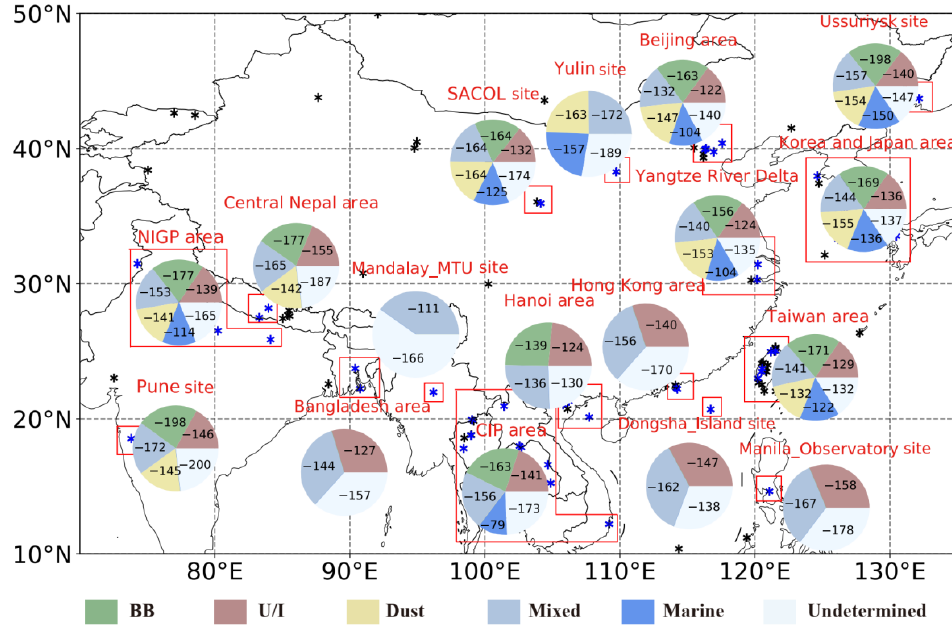
Figure 12. The same as Figure 9 but for the ARFE BOA (Unit: W/m 2 /AOD 550nm ).